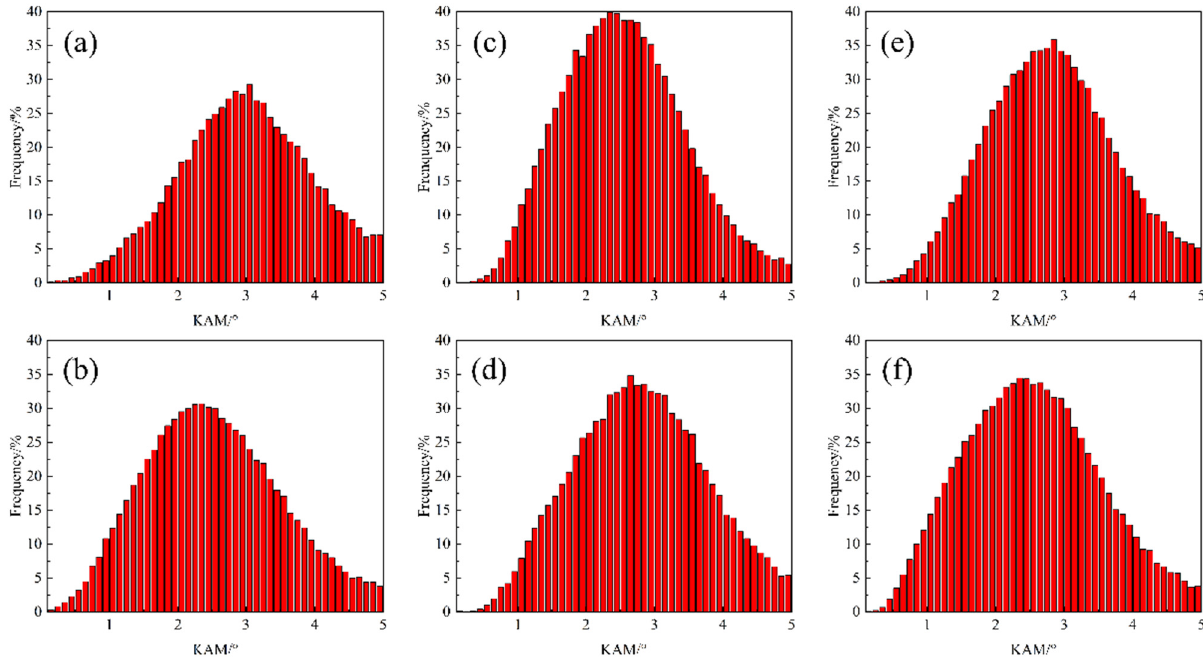
Figure 6: KAM statistical chart of cold - rolled plate: ( a ) 86% Y - free; ( b ) 86% Y - bearing; ( c ) 72% Y - free; ( d ) 72% Y - bearing; ( e ) 60% Y - free; ( f ) 60% Y -